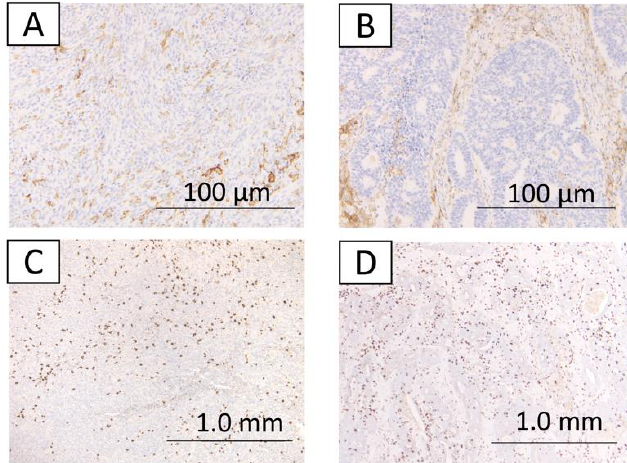
Figure 3. The immunohistochemical findings from case 1. A,B,C,D indicate no expression of PD-L1 in the well-differentiated component ( A ). Expression of PD-L1 in the undifferentiated component ( B ). CD8 expression score of 2 in the well-differentiated component ( C ). CD8 expression score of 2 in the undifferentiated component ( D ).